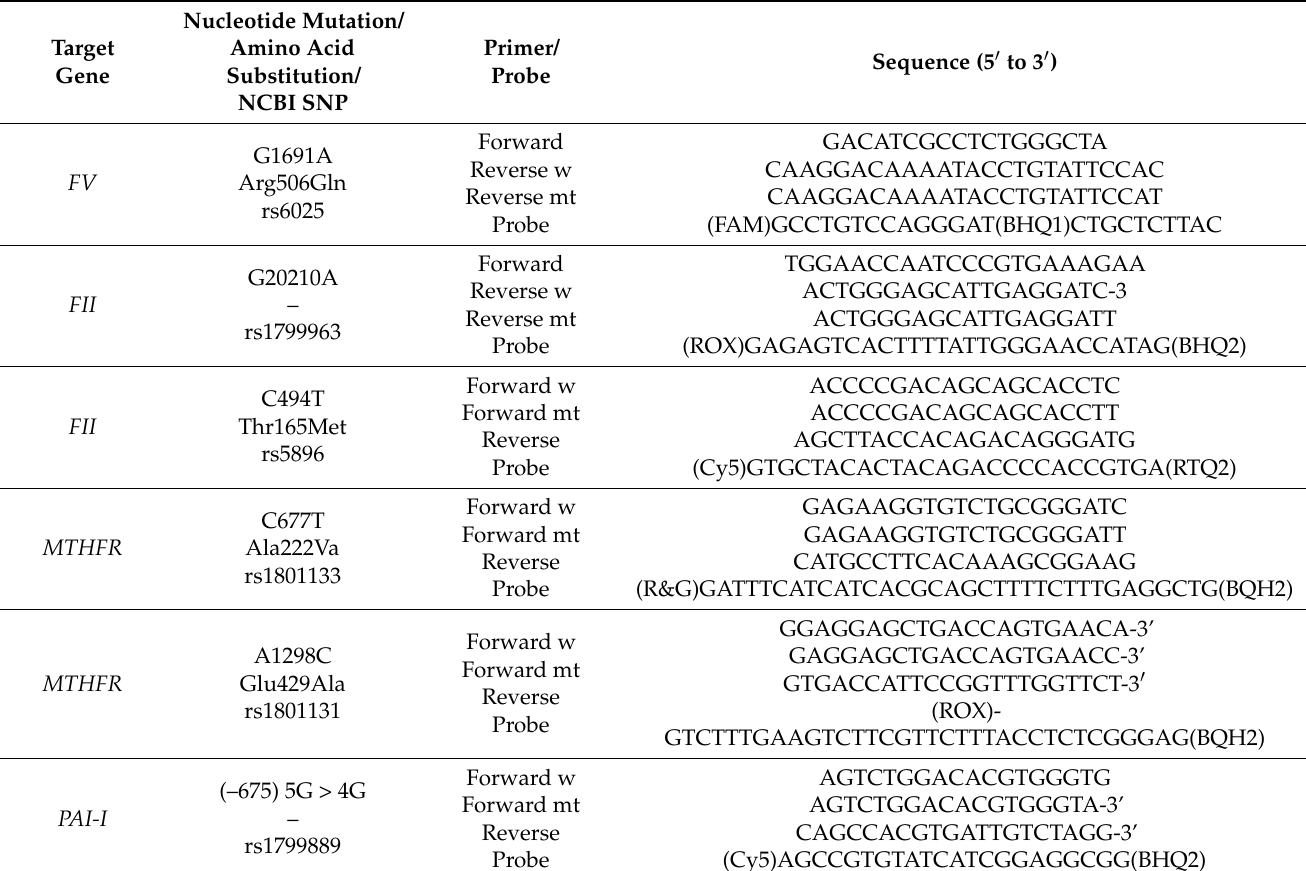
Table 1. Mutation points, primers, and fluorescent Taqman